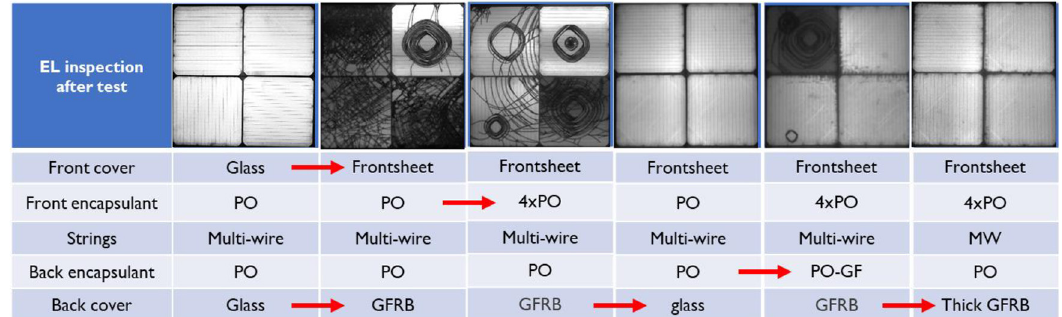
Fig. 12. EL images of the shingled laminates after hail testing. Variations in BOM between the laminate structures are highlighted with red arrows.